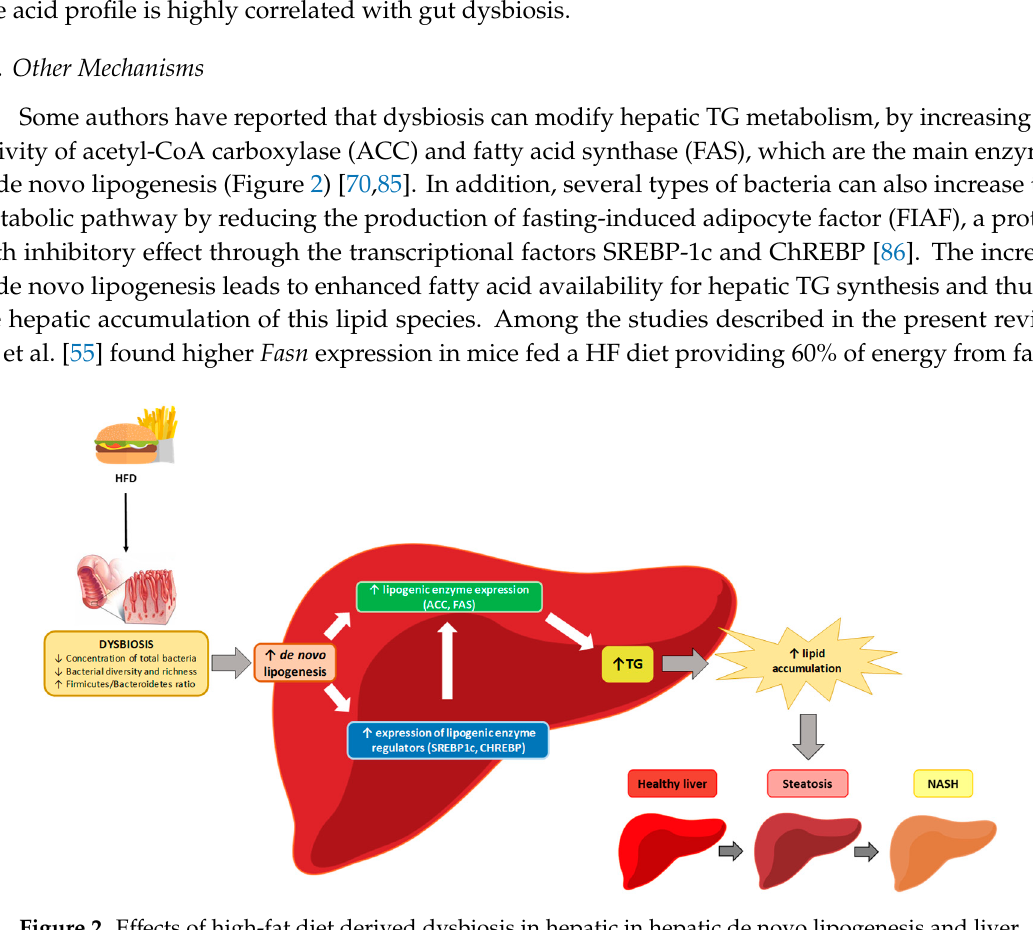
Figure 2. Effects of high-fat diet derived dysbiosis in hepatic in hepatic de novo lipogenesis and liver lipid accumulation (Based on Parnell et al. [70]. HFD: High-fat diet, ACC: acetyl-CoA carboxylase, FAS: fatty acid synthase, SREBP1c: sterol regulatory element-binding protein 1c, CHREBP: carbohydrate responsive element-binding protein, NASH: nonalcoholic steatohepatitis.